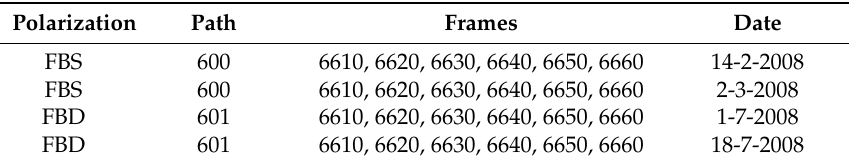
Table 2. Acquisition dates and polarizations for Advanced Land Observing Satellite Phased Array type L-band Synthetic Aperture Radar-1 (ALOS PALSAR-1) data used. FBS: Fine Beam Single polarization; FBD: Fine Beam Dual polarization.